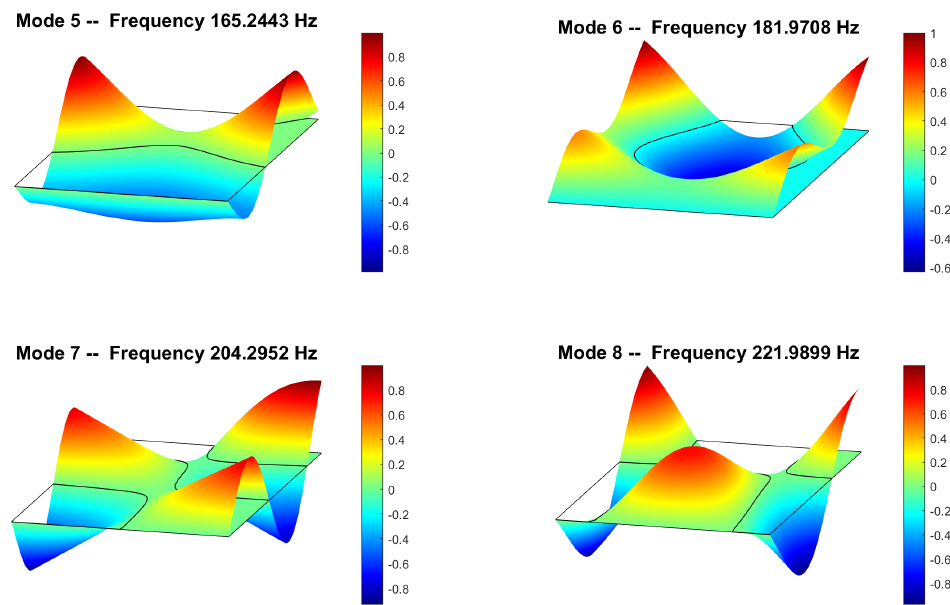
Figure 5. 3D mode shapes 5, 6, 7 and 8 of the plate vibration.